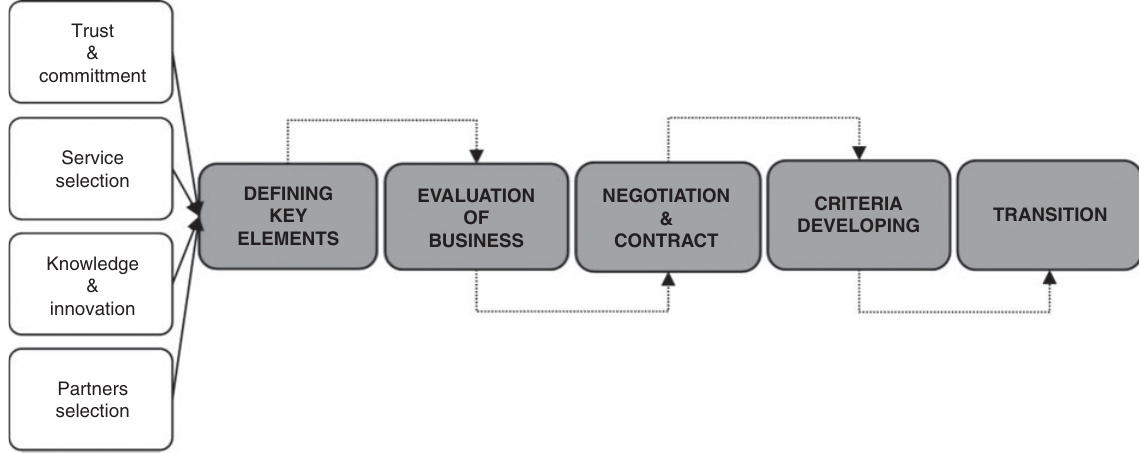
Fig. 9. The intelligent outsourcing process